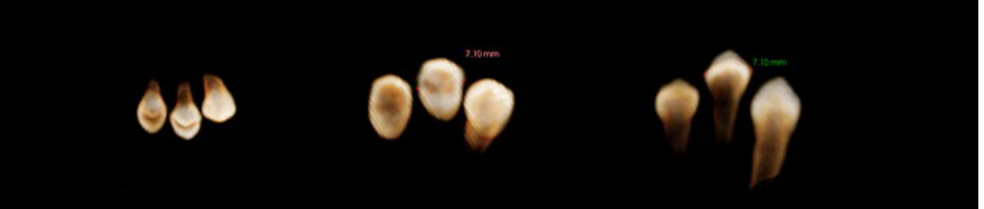
Figure 2. The occlusal face of each tooth was aligned with the monitor and the mesiodistal width was measured with the ‘linear measurement tool’. The measurements were then confirmed from a labial/palatal view in order to ensure the correct mesiodistal width was being measured.